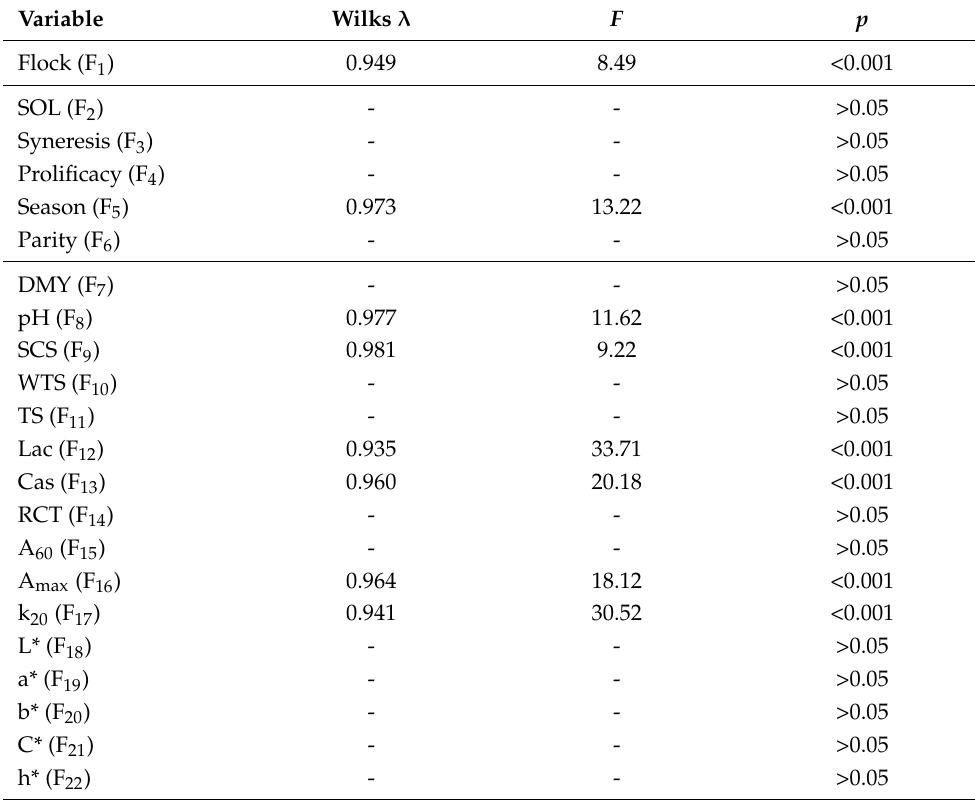
Table 4. Determinants for curd efficiency (CE and DCE), according to MANCOVA ( n = 967).